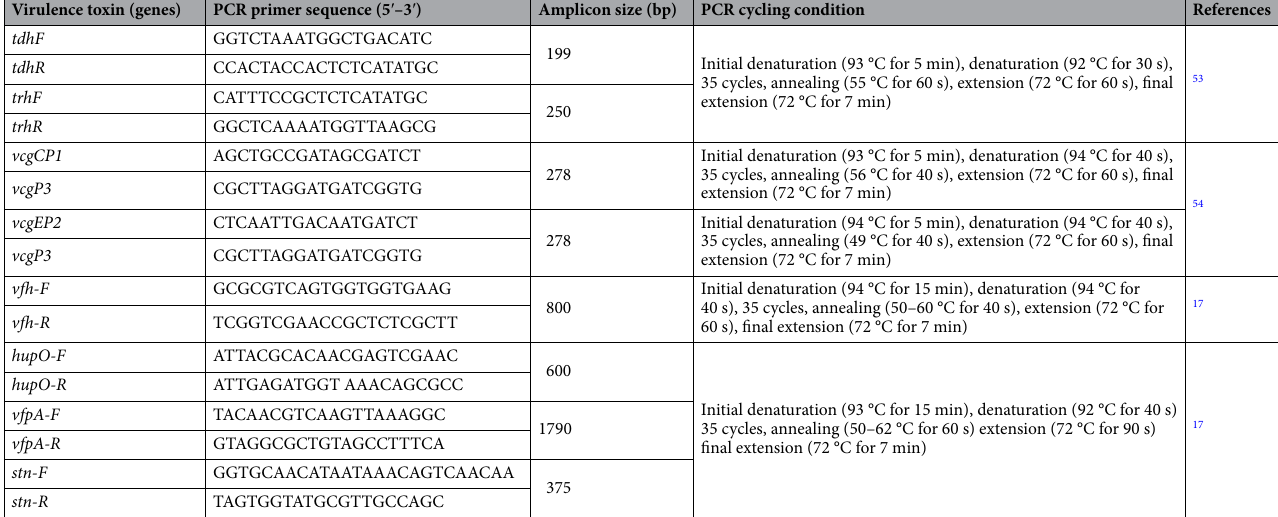
Table 2. PCR condition and primer sets used for the screening of Vibrio virulence toxins (genes).